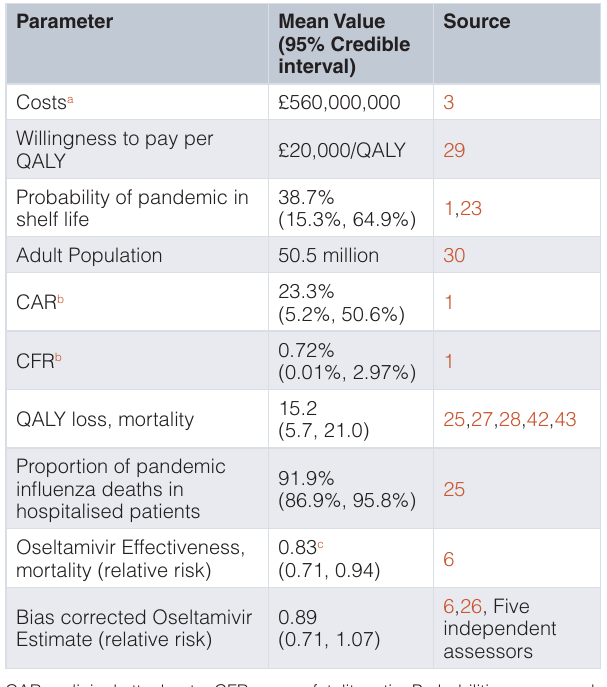
Table 1. Summary of posterior distributions of the model